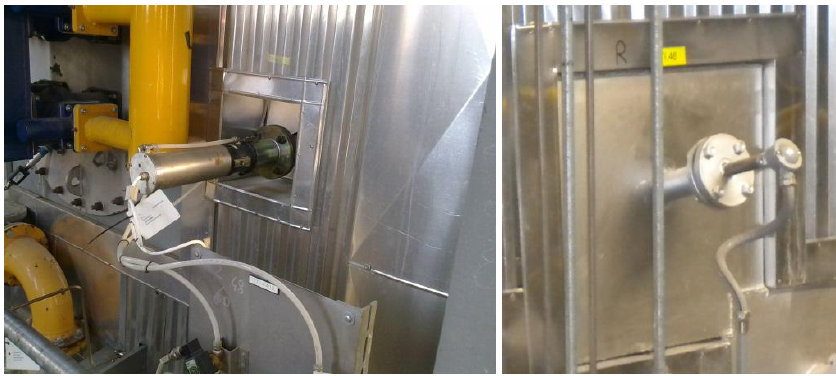
Figure 4. External views of an infrared radiation (IR) pyrometer on the left and of a bare thermocouple on the right, both installed on a WTE